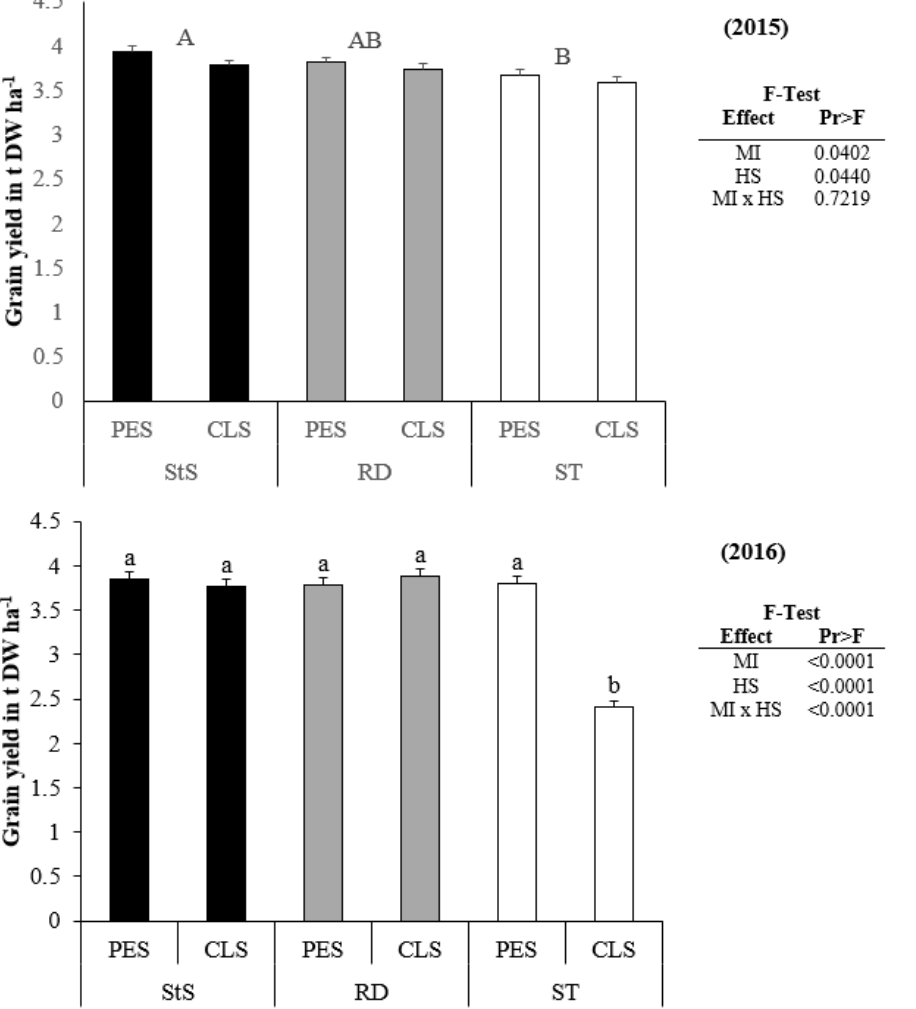
Figure 1. Grain yield of Clearfield ® -oilseed rape (t DW ha − 1 ) as effect of different management intensities and herbicide strategies in the years 2015 and 2016, experimental station Ihinger Hof. StS: standard sowing (mouldboard ploughing, 50 seeds m − 2 , 12 cm row spacing); RD: reduced sowing density (mouldboard ploughing, 25 sown seeds m − 2 , 50 cm row spacing); ST: strip-till (strip tillage, 25 seeds m − 2 , 50 cm row spacing); PES: pre-emergence application of Colzor ® Trio and post-emergence application of Agil ® -S. CLS: post-emergence application of Clearfield ® -Vantiga ® -D. Values labelled by the same letter are not significantly different. 2015: letters refer to the main effects of StS, RD and ST, for 2016: letters refer to the interactions ( p ≤ 0.05; Student’s t -test). Error bars: standard error of mean.